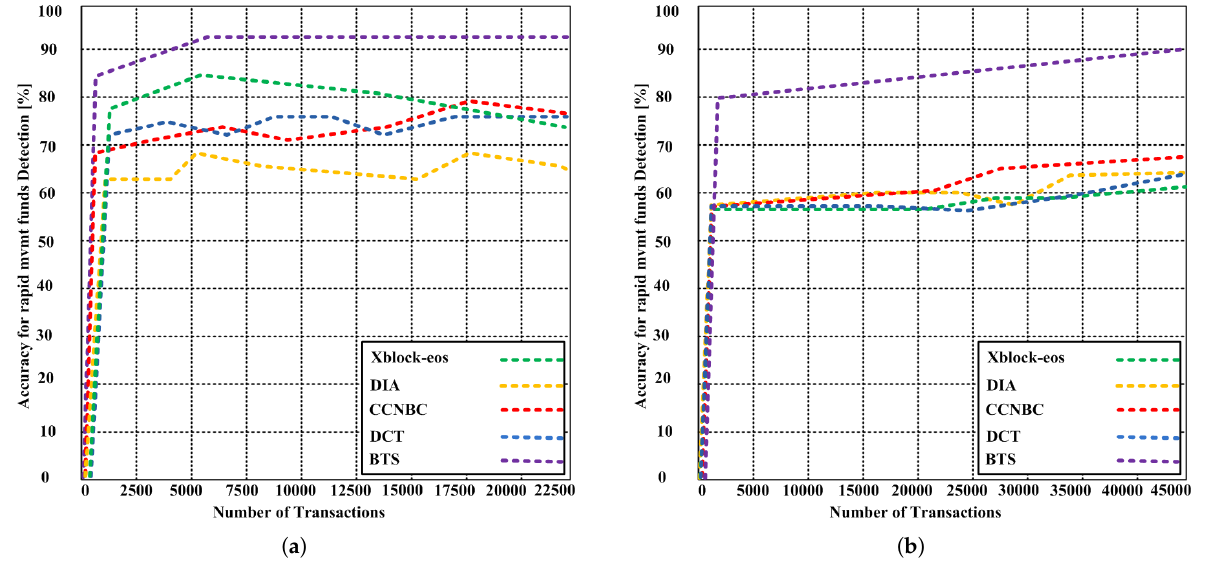
Figure 7. ( a ) Accuracy for rapid mvmt funds detection of the proposed BTS and contending methods with the maximum 22,500 transactions; ( b ) Accuracy for rapid mvmt funds detection of the proposed BTS and contending methods with the maximum 45,000